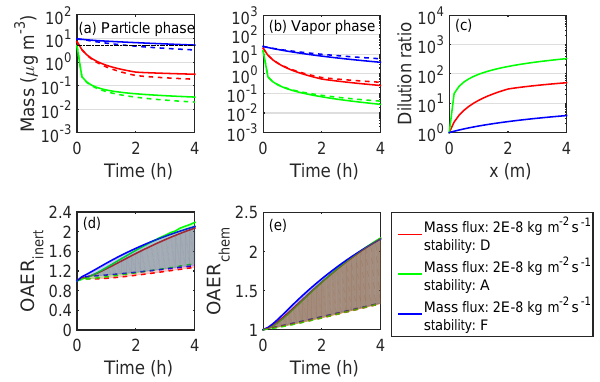
Figure 8. As in Fig. 7 but for an assumed mass flux of 2 × 10 − 8 kgm − 2 s − 1